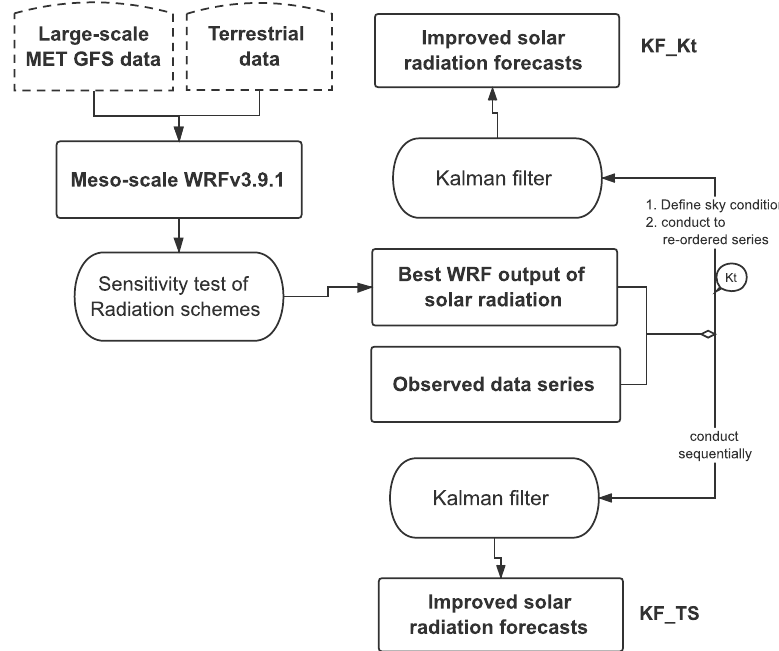
Figure 2. A schematic diagram of the hybrid system of forecasting day-ahead solar